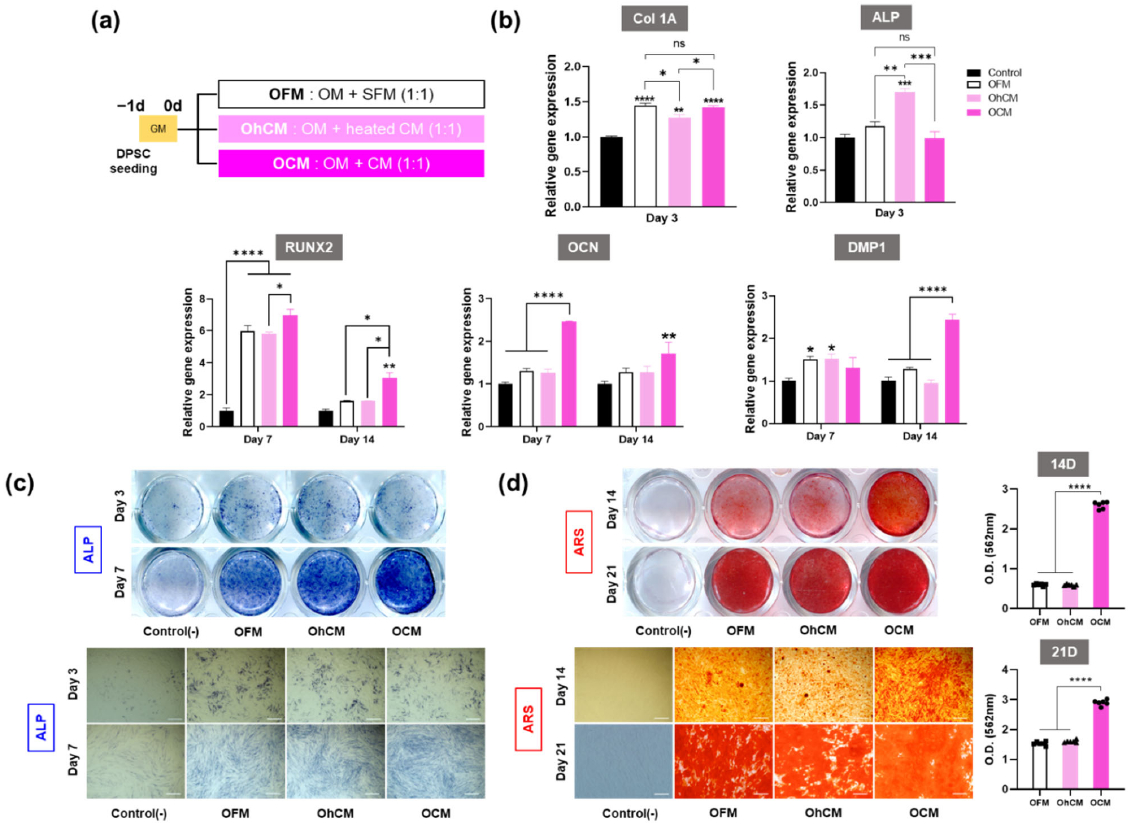
Figure 3. hGF ‐ CM potentiates SHED odonto/osteogenic differentiation ( a ) Schematic diagram Figure 3. hGF-CM potentiates SHED odonto/osteogenic differentiation ( a ) Schematic showing the schedule and groups of experiments. ( b ) Relative odonto/osteogenic gene expression levels quantified by qRT ‐ PCR, with early markers at Day 3 and late markers at Days 7 and 14. ( c ) Representative images of alkaline phosphatase (ALP) activity analyzed by ALP staining at Days 3 and 7 and ( d ) mineralization analyzed by Alizarin Red staining at Days 14 and 21 after culturing in OFM, OhCM, or OCM. The graphs show the quantification of mineralization at Days 14 and 21. ( c ) All data are represented as the mean ± SD. All data are represented as the mean ± SD. One ‐ way analysis of variance followed (ANOVA) by Tukey’s multiple comparisons test was used to detect statistically significant differences between groups. Represents * p < 0.05, ** p < 0.01, *** p < 0.001, **** p < 0.0001, ns = not significant, scale bar = 200 μ m. OFM: hGF ‐ CM diluted by 50% with odonto ‐ genic medium, OhCM: heated CM (CM heated at 95 °C for 30 min to denature the proteins) diluted by 50% with odontogenic medium, OCM: SFM diluted by 50% with odontogenic medium 3.5. Differential Protein Expression in hGF ‐ CM LC ‐ MS ‐ based proteomics with hGF ‐ CM was conducted to determine which proteins are sufficient in hGF ‐ CM and effective for odontogenesis, and as a result, a considerable number of ECM components were identified. Among them, 85 hit components were se ‐ lected and analyzed again, and biological processes and pathways related to ECM were detected (Figure 4a − c). The phenomenon that there are many ECM ‐ related molecules from these kinds of CMs is consistent with the known effects of ECM components on increasing biomineralization in differentiation (especially collagen, etc.). Detectable growth factors other than ECM described in other literature were not detected, which is thought to be due to the detection limit of LC ‐ MS.